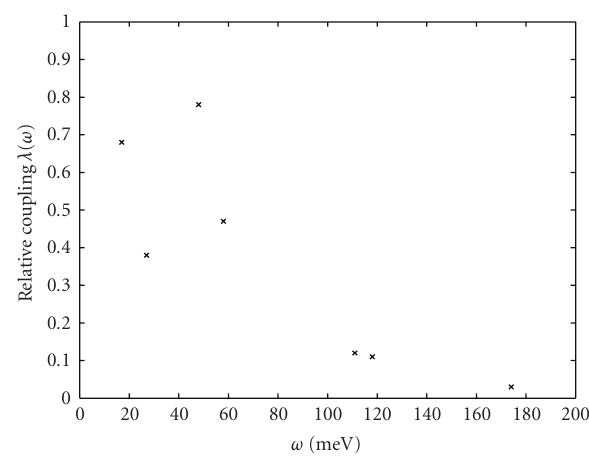
Figure 5: The relative strength of λ SPC (the first 4 points) and λ sf (the 3 points at the highest energies). The latter will move towards lower energy if the exchange enhancement increases, while the points for SPC are fixed near the phonon energies; see the